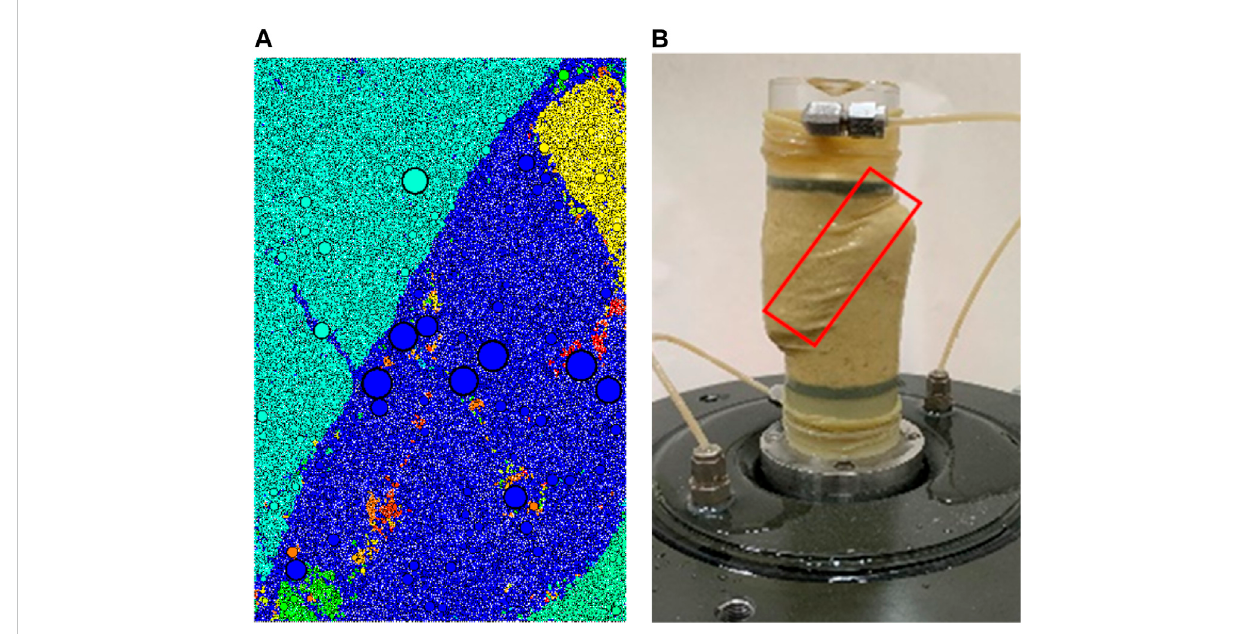
FIGURE 14 Comparison oftheshearbandbetweensimulationandtheindoortest. (A) Numericalsimulationoftheshearband. (B) Shearbandforanindoortest.